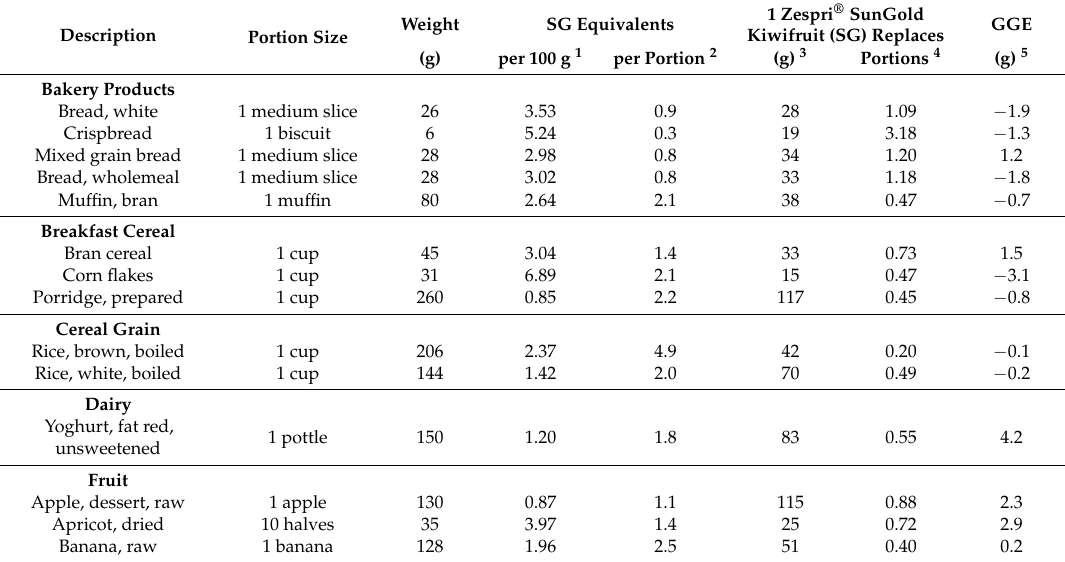
Table 2. Kiwifruit exchanges that would maintain a constant carbohydrate intake, based on the available carbohydrate content of selected carbohydrate